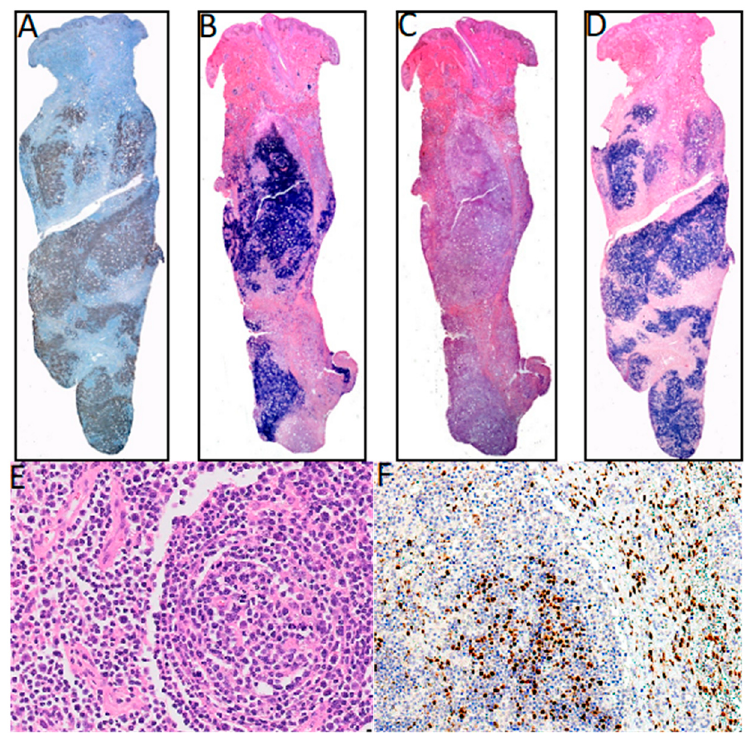
Figure 5. KSHV associated lymphomas. ( A – D ) Primary effusion lymphoma KSHV and EBV positive. ( A ) KSHV LANA (latency-associated nuclear antigen) staining. ( B ) Lambda light chain staining. ( C ) Kappa light staining. ( D ) EBER in situ hybridization. ( E,F ) Multicentric Castleman disease. ( E ) Hematoxylin-Eosin staining. ( F ) KSHV LANA staining, magnification 40×.